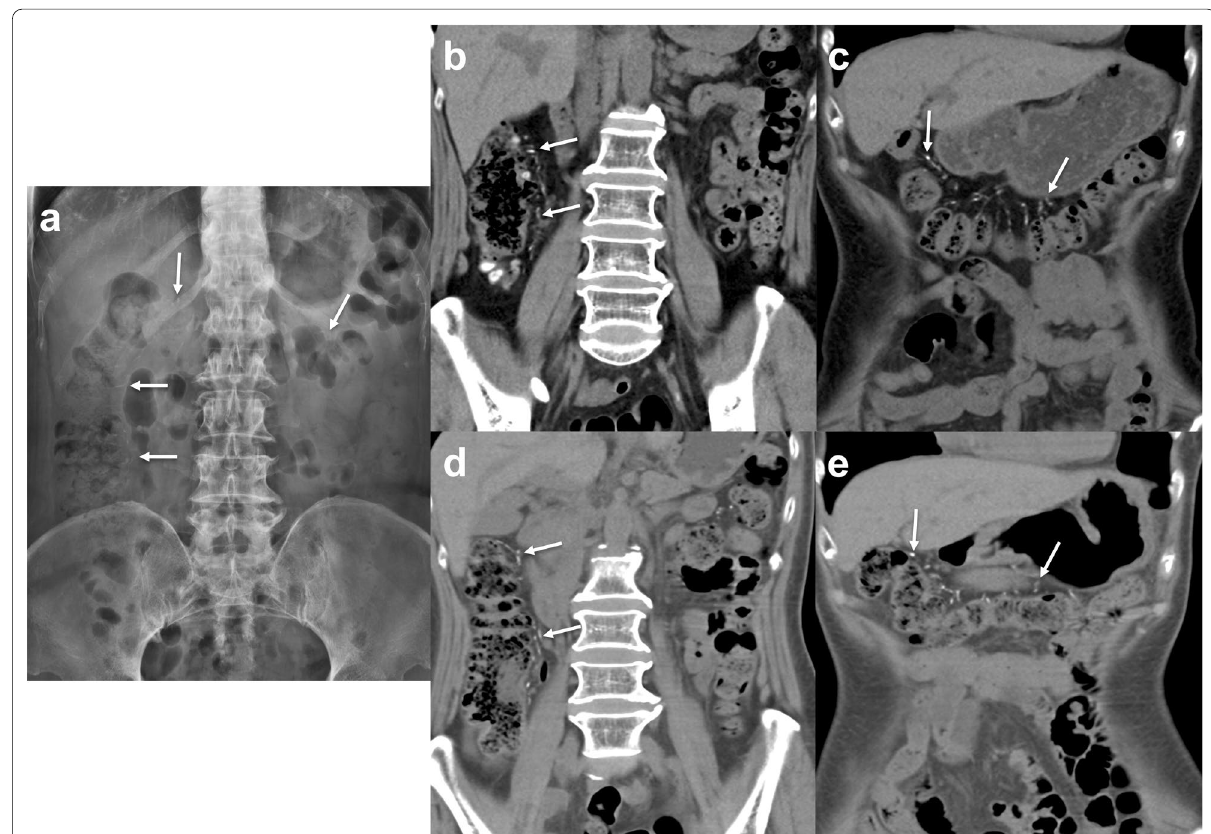
Fig. 6 A 52‑year‑old asymptomatic woman had a past history of hysterectomy for early endometrial cancer. a Curvilinear calcifications alongside the right colon were incidentally observed on abdominal radiograph. b , c CT confirming calcified straight and marginal veins of the right colon without colitis. d , e Five‑year follow‑up CT shows stable calcified mesenteric veins with no colonic wall